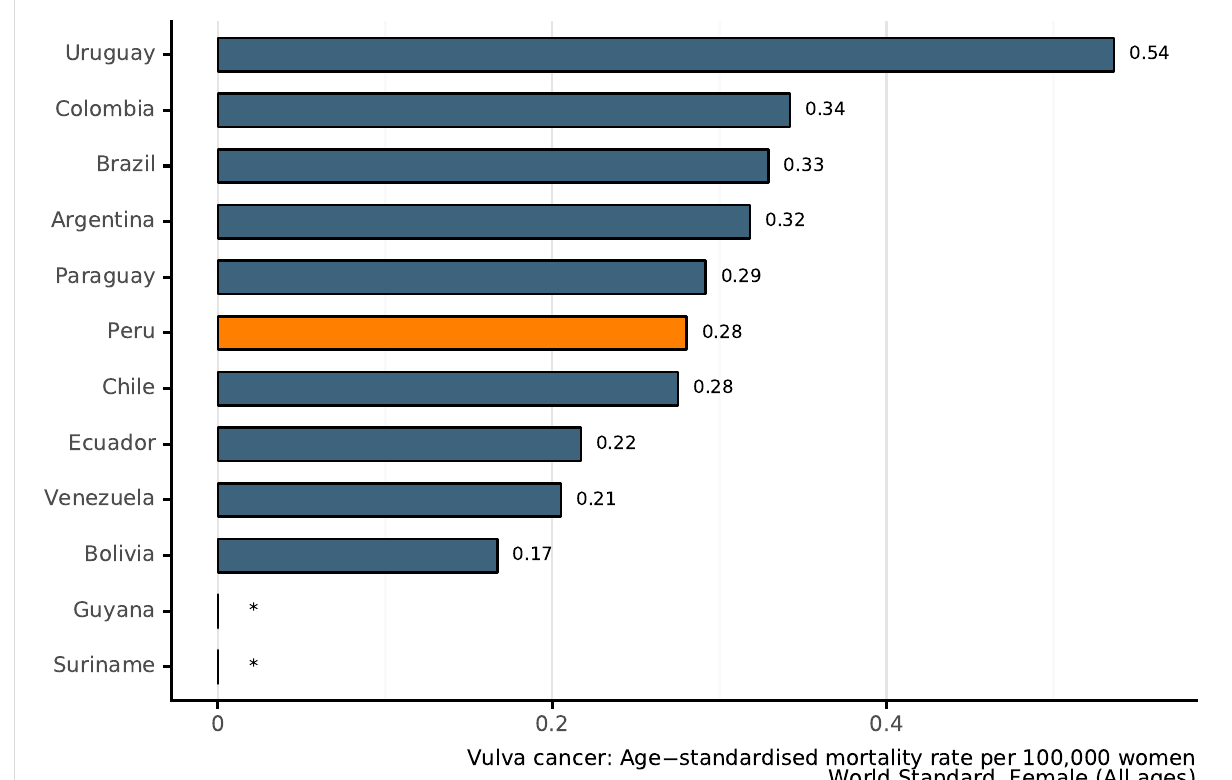
Vulva cancer: Age standardised mortality rate per 100,000 women World Standard. Female (All